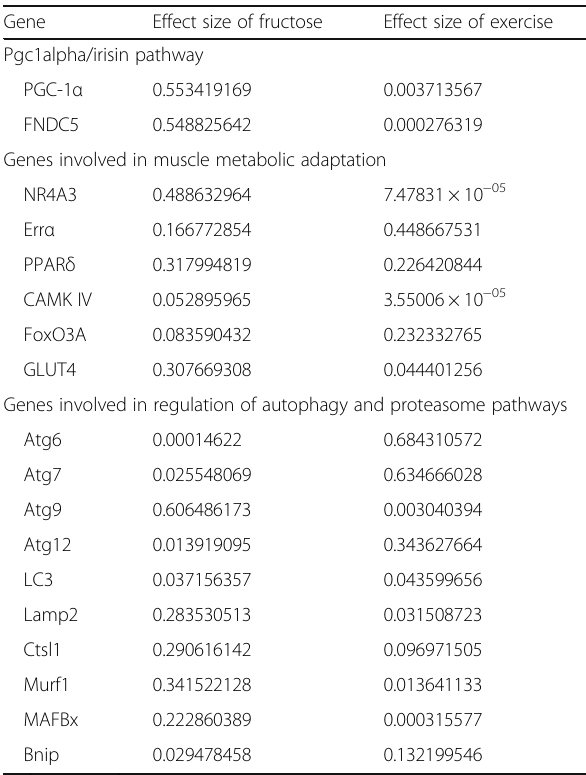
Table 3 Effect size of treatments (fructose or exercise) on expression of genes involved in skeletal muscle metabolic